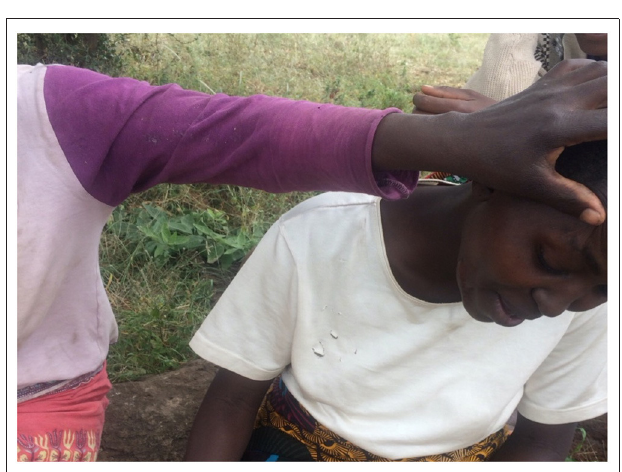
FIGURE 7 | Nasaya being examined for symptoms of illness by local illness referral